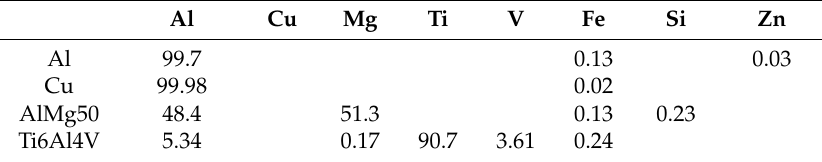
Table 2. Chemical composition of powders in wt% measured by XRF.